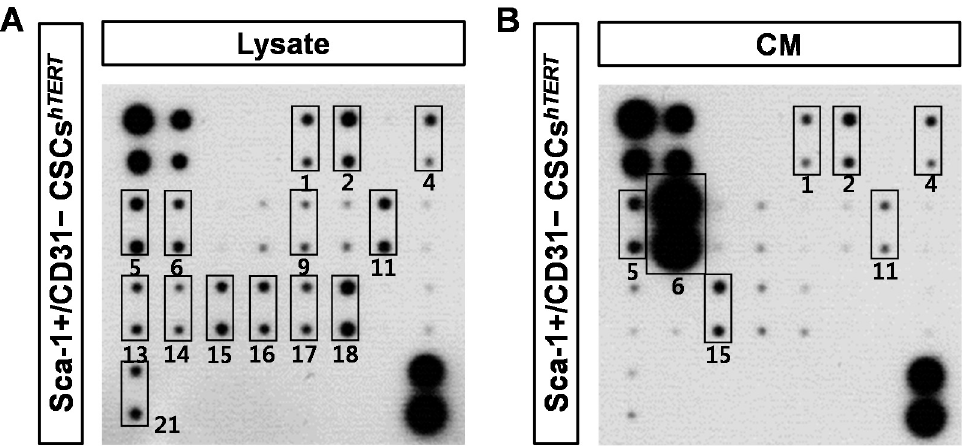
Figure 4. Cont. Figure 4.